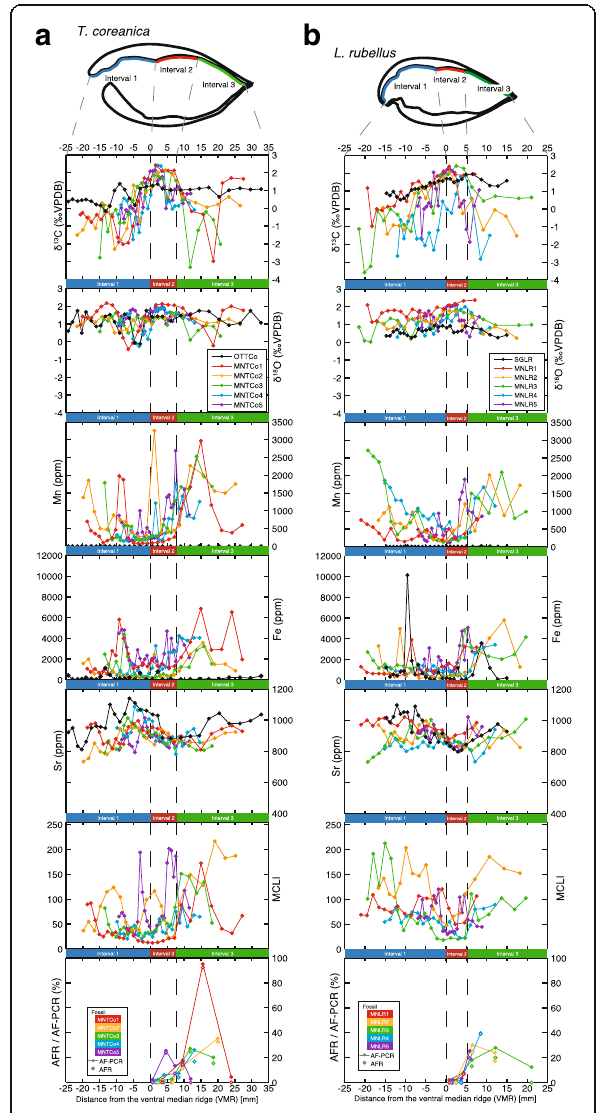
Fig. 6 Profiles of geochemical, microstructural, and optical signals in the studied brachiopod. These panels compare the δ 13 C and δ 18 O values, minor element concentrations, mean CL intensity (MCLI), altered fiber ratio (AFR), and altered fiber and puncta-filling cement ratio (AF-PCR) between the modern (OTTCo and SGLR) and fossil (MNTCo1 – MNTCo5 and MNLR1 – MNLR5) shells. a Terebratalia coreanica shells. b Laqueus rubellus shells. The geochemical profiles of each sample were fitted to the average length of interval 2 (7.74 mm for T. coreanica and 5.27 mm for L. rubellus